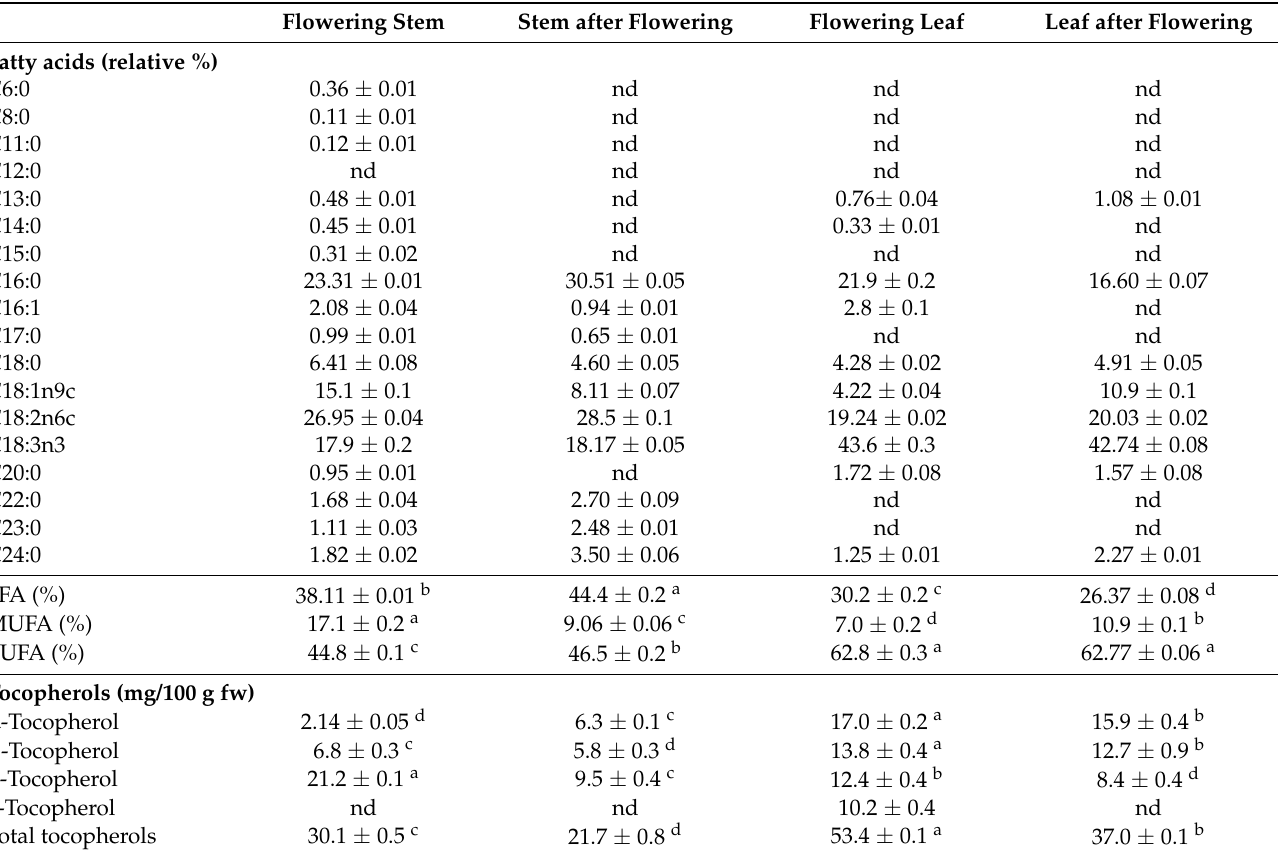
Table 2. Composition of fatty acids and of tocopherols of the studied C. erecta edible parts (mean ± SD, n =